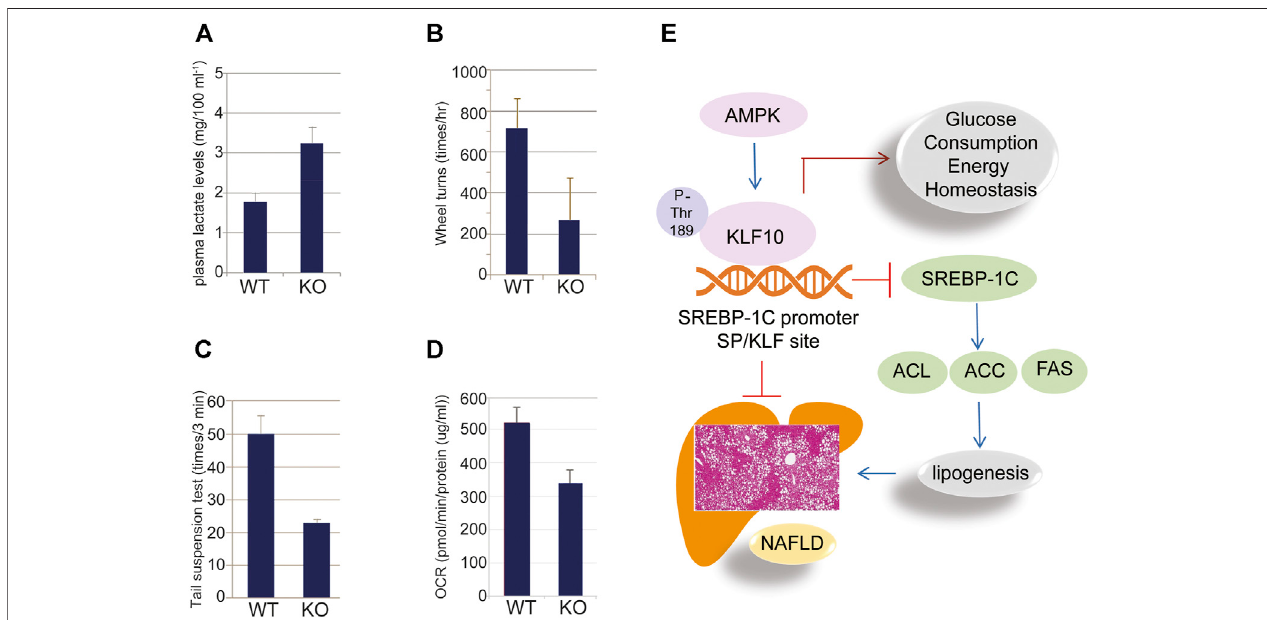
FIGURE 6 | KLF10 regulated glucose metabolism in mice. (A) Plasma lactate levels in wild-type (WT) and KLF10 − / − (KO) mice. (B) KLF10 − KO mice traveled a signi fi cantly shorter distance than WT mice that was detected by wheel turns experiment. (C) KLF10-de fi cient mice exhibited shorter immobility times in the tail suspension test. (D) Seahorse X-24 analysis of the oxygen consumption rate (OCR) in WT and KLF10-KO mouse livers under basal conditions. All data are represented asmean ± SD. ( n (cid:1) 6) (E) The proposed scheme ofNAFLDpreventedbyAMPK-KLF10 axis.AMPK phosphorylates KLF10 atThr189 leadingtoenhanced stability and activity. Activated KLF10 inhibits SREBP-1C expression by binging to its promoter thereafter reduced the expression of lipogenesis related genes including ACL, ACC, and FAS, ultimately contributed to the prevention of